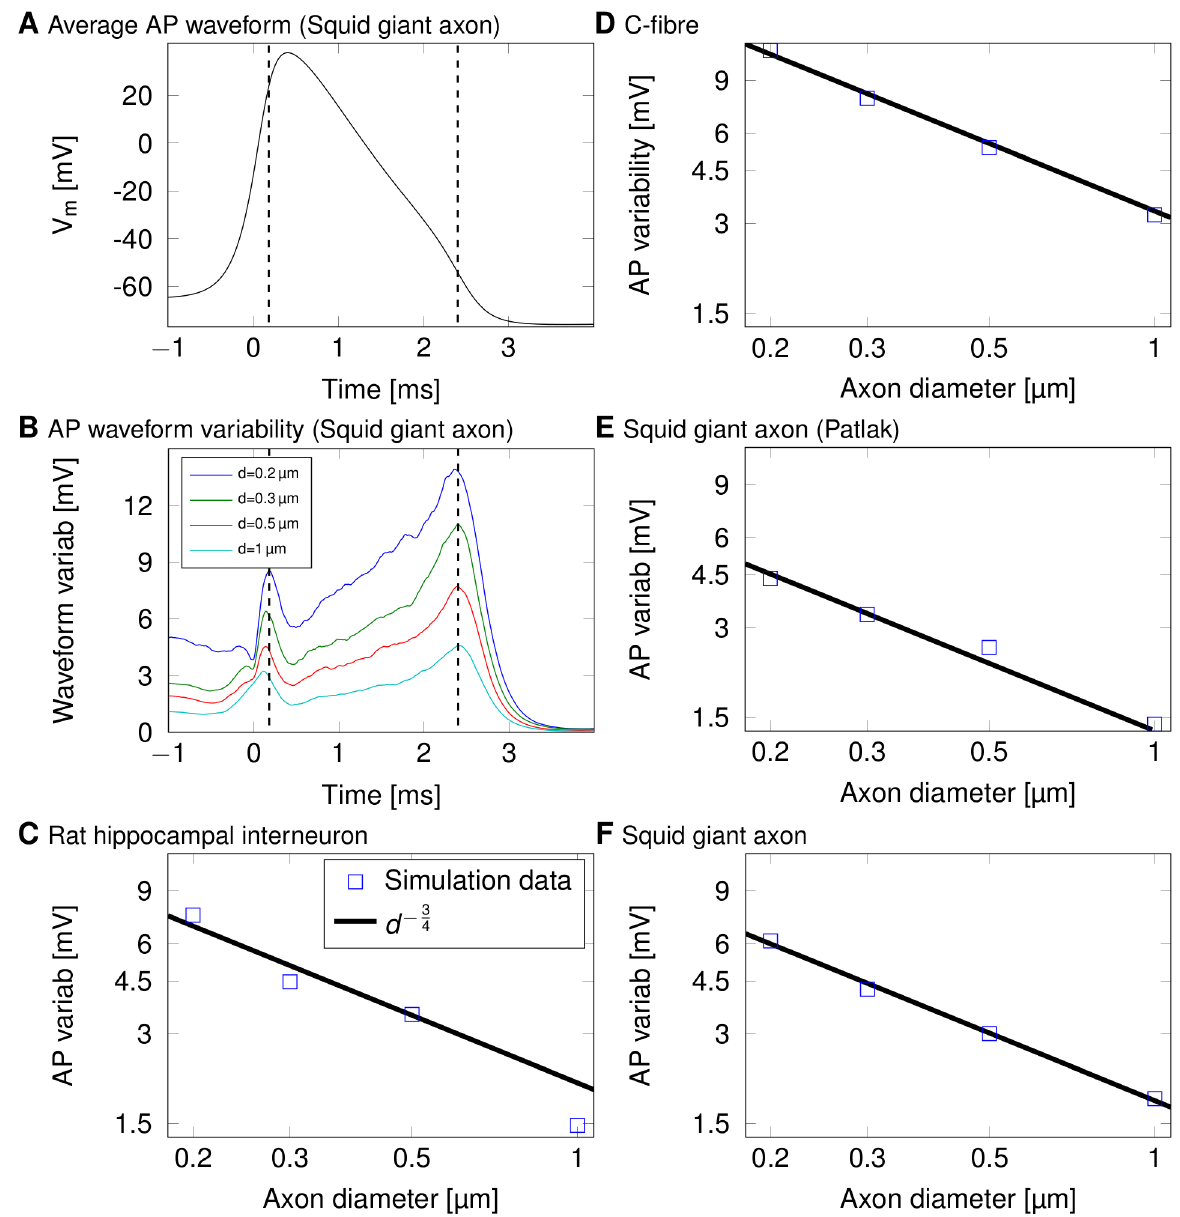
Figure 4. Travelling APs’ waveform fluctuations scale with axonal diameter with an inverse power low. (A) Typical shape of an action potential in the squid giant axon. (B) The variability in the waveform at each moment in time (N=250). We define the variability as 3 6 SD of the membrane potential at each point in time. (C) Log-log plot of 3 6 SD of fluctuations in AP shape over diameter for the rat hippocampal interneuron. (D) Log-log plot of 3 6 SD of fluctuations in AP shape over diameter for a C-fibre axon. (E) Log-log plot of 3 6 SD of fluctuations in AP shape over diameter for a squid giant axon (Patlak channels). (F) Log-log plot of 3 6 SD of fluctuations in AP shape over diameter for a squid giant axon.